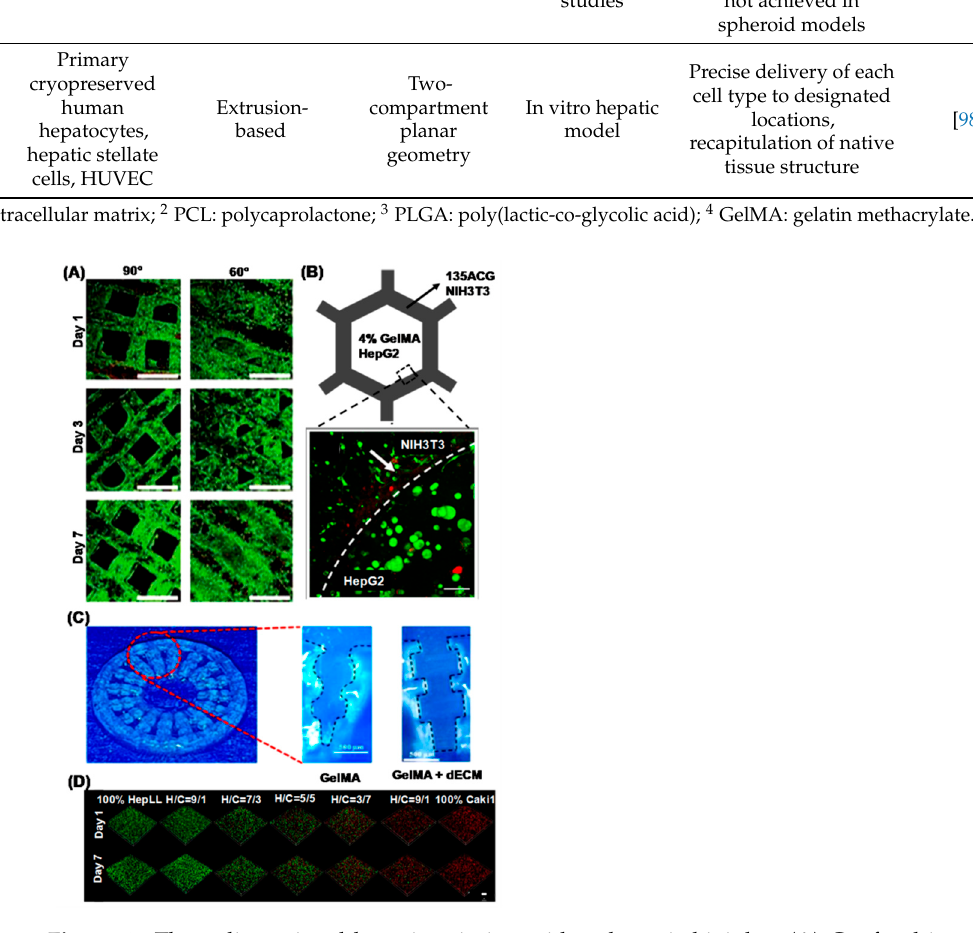
Figure 4. Three-dimensional hepatic printing with polymeric bioinks. ( A ) Confocal images of live/dead (green/red) staining of Huh7 cell seeded structures of different angles over 7 days (Magnification: 10 X; Scale bar: 500 µm). Image reproduced with permission from [79]. ( B ) Adjacent NIH/3T3 in 1% alginate, 3% nanocrystalline cellulose and 5% GelMA (135ACG) and HepG2 in 4% GelMA on day 7 (green: live cells; red: dead cells; Scale bar: 100 µm) Image reproduced with permission from [87]. ( C ) The macroscopic images of the digital light process printed GelMA/dECM and GelMA scaffolds in inner gear-like design (Scale bar: 500 µm). Image reproduced with permission from [88]. ( D ) Confocal images of liver (HepLL) and kidney (Caki-1) cells co-cultured on metastasis-on-a-chip on day 1 and day 7 (Scale bar: 100 µm). Image reproduced with permission from [96].